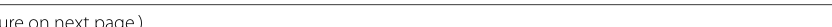
figure on next Fig. 3 M1 macrophage exosomal miR‑326 inhibits cell proliferation and colony formation in HCC cells. a MTT assay detected the effect of transfection of miR‑326 mimic on the proliferation of HepG2 cells. b MTT assay detected the effect of transfection of miR‑326 inhibitor on the proliferation of SMMC‑7721 cells. c MTT assay detected the effect of co‑culture with miR‑326 mimic‑transfected M1 macrophage‑derived exosomes on the proliferation of HepG2 cells. d MTT assay detected the effect of co‑culture with miR‑326 inhibitor‑transfected M1 macrophage‑derived exosomes on the proliferation of SMMC‑7721 cells. e Colony formation assay detected the effect of transfection of miR‑326 mimic on the colony formation ability of HepG2 cells. f Colony numbers of HepG2 cells. g Colony formation assay detected the effect of transfection of miR‑326 inhibitor on the colony formation ability of SMMC‑7721 cells. h Colony numbers of SMMC‑7721 cells. i Colony formation assay detected the effect of co‑culture with miR‑326 mimic‑transfected M1 macrophage‑derived exosomes on the colony formation ability of HepG2 cells. j Colony numbers of HepG2 cells treated with exosomes. k Colony formation assay detected the effect of co‑culture of miR‑326 inhibitor‑transfected M1 macrophage‑derived exosomes on the colony formation ability of SMMC‑7721 cells. l Colony numbers of SMMC‑7721 cells treated with exosomes. In panel a and f, * P < 0.05 versus the NC‑mimic group; In panel b and h, * P < 0.05 versus the NC‑inhibitor group; In panel c and j, * P < 0.05 versus the control group, # P < 0.05 versus the Exo‑NC‑mimic group; In panel d and l, * P < 0.05 versus the control group, # P < 0.05 versus the Exo‑NC‑inhibitor group. Measurement data were depicted as mean standard deviation ( N 3), comparisons among multiple groups were ± = conducted by one‑way analysis of